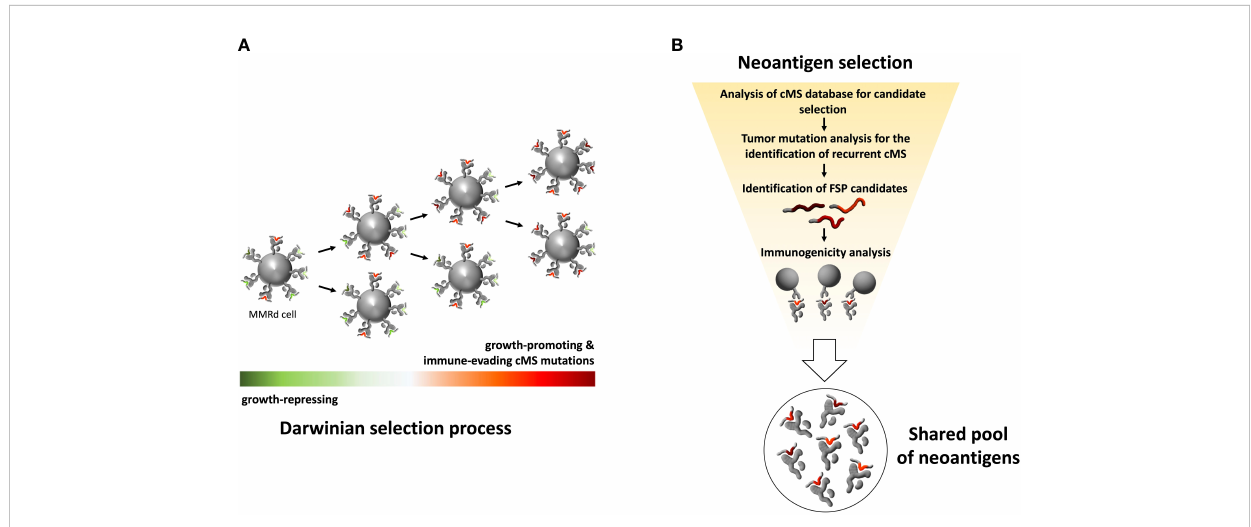
FIGURE 1 Schematic illustration of MMRd tumor clone selection process and work fl ow for selecting a pool of shared immunogenic neoantigens. (A) Schematic illustration of Darwinian selection process underlying MMRd cancer evolution. The random accumulation of indel mutations in cMS, caused by impairment of the MMR system, is followed by a non-random persistence of mutations. Cell clones carrying mutations that promote tumor outgrowth or provide other survival advantages, such as immune evasion, are positively selected. This evolutionary selection of mutations leads to recurrent cMS mutation patterns in MMRd cancers and thus a predictable pool of FSPs. (B) Strategy for the selection of shared, immunogenic FSPs for immunoprevention. Screening of a genome-wide cMS database forms the basis for the identi fi cation of recurrent cMS mutations shared by MMRd cancers. Accounting for mutation frequency in MMRd cancers, immunogenicity prediction in silico and immunogenicity testing in vitro , a pool of candidate neoantigens can be selected for FSP